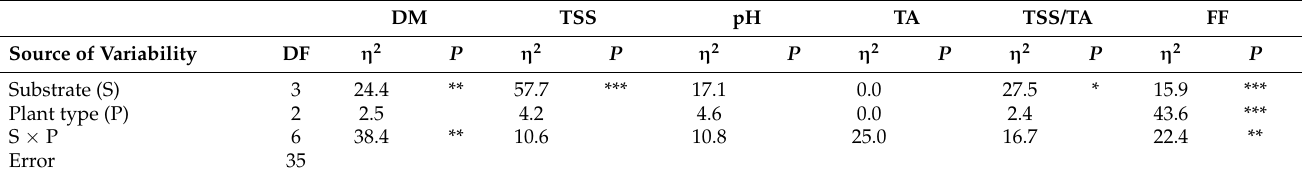
Table 8. Analysis of variance for average flavor quality traits (dry mass: DM, total soluble solids: TSS, titratable acidity: TA, flesh firmness: FF) of tomato fruit harvested on 31 July. The fruit was obtained from self-rooted ‘Beef Bang F1’, ‘Beef Bang F1’ grafted onto ‘Defensor’, trained in single or double stem and grown hydroponically in four substrates (rockwool slabs, perlite in sacks, pumice in sacks and pumice in pots) in a